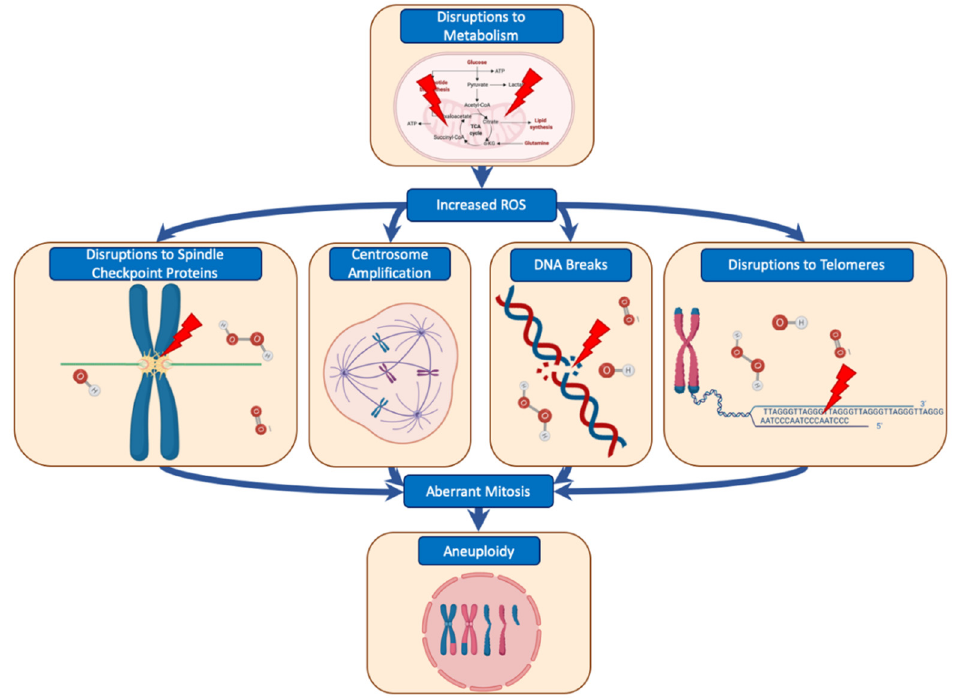
Figure 3. Metabolic disruption can cause aneuploidy. Disturbances in energy metabolism lead to a buildup of pathological ROS. This can play a part in aberrant mitosis via several ways, such as disruptions to spindle checkpoint proteins [101,102], centrosome amplification [104,105], DNA breaks [101], and disturbances to telomeres [108].